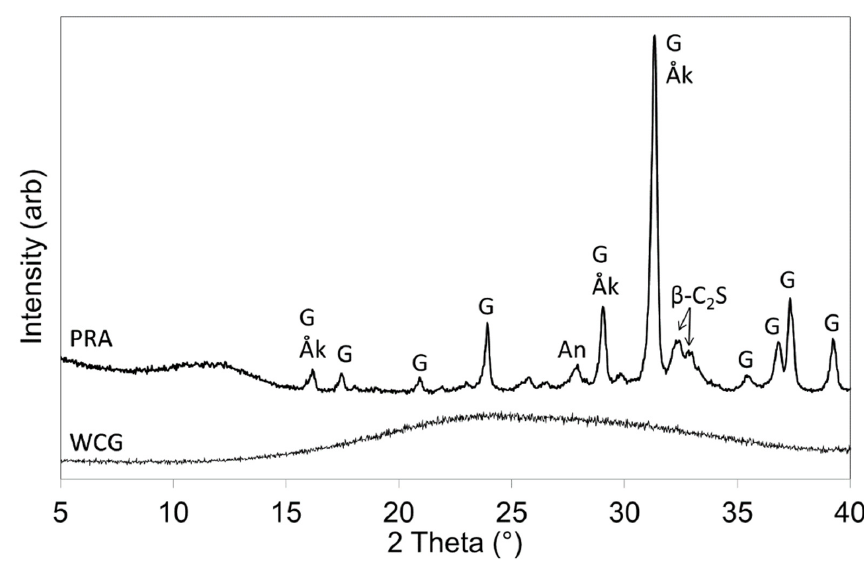
Figure 1. XRD patterns of WCG and PRA (Key: Åk = åkermanite; An = anorthite; β -C2S = β -dicalcium silicate; G = gehlenite).